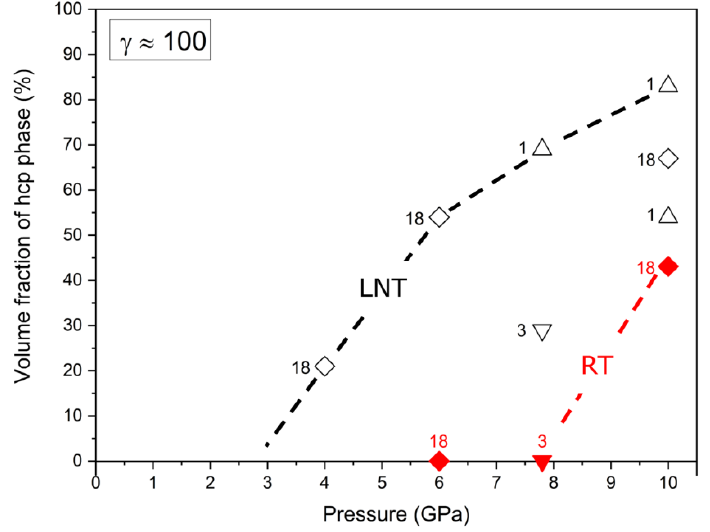
Figure 4. Volume fraction of martensitic phase versus pressure at a shear strain γ ≈ 100. The symbols represent different series of HPT samples, for which the phase composition was measured after the number of months indicated.